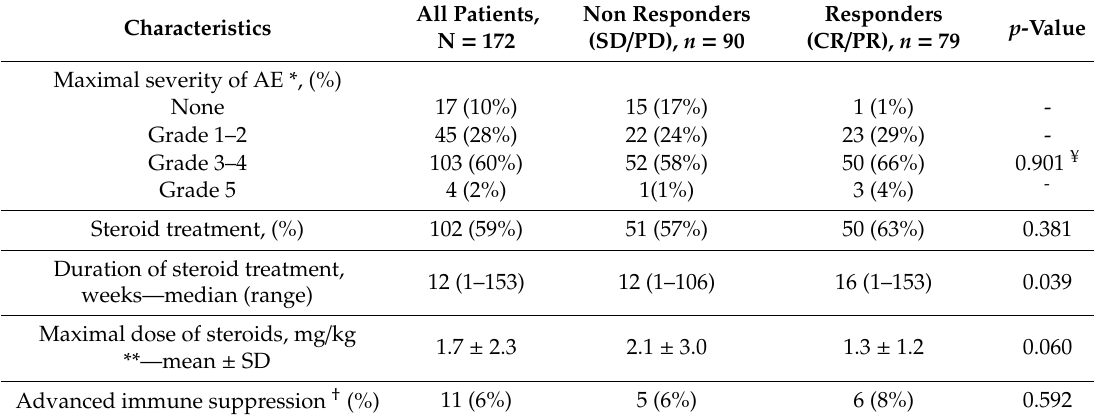
Table 3. Toxicity and